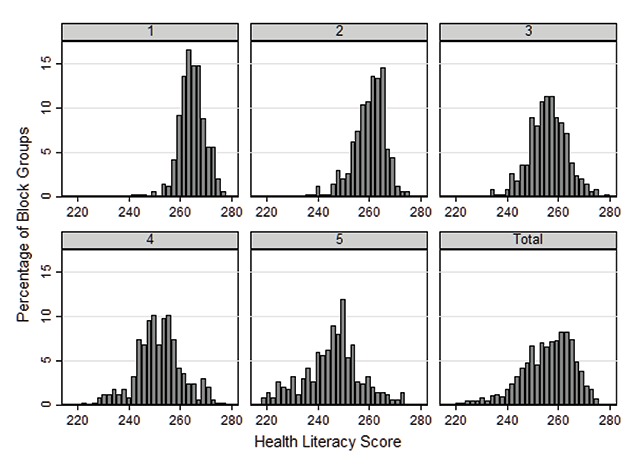
Percent distribution of health literacy score by U.S. Census block group by Singh area deprivation index quintile (least deprived = 1) and in total.